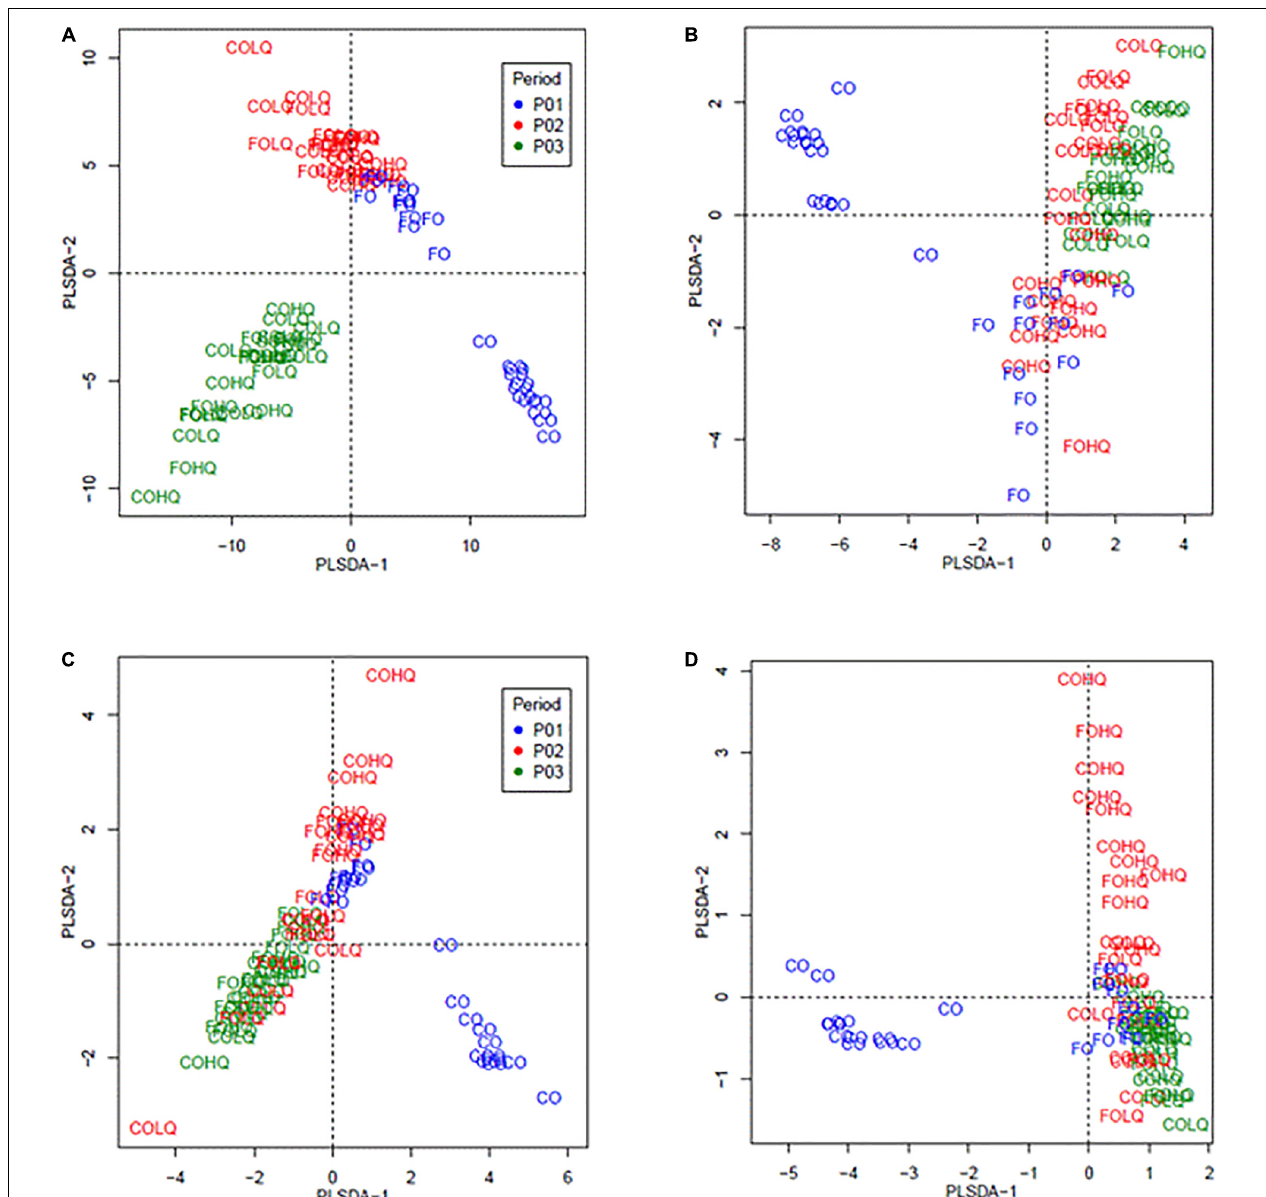
FIGURE 2 | Partial least square discriminant analysis (PLSDA) of the bacteria community at the genus level and archaea community at the species level from calves fed different treatments and treatment combinations in three sampling phases. Dietary treatments corresponded to: phase 1 (P01), concentrate (CO) vs. pasture (FO); and phase 2 (P02) high-quality (HQ) vs. low-quality (LQ) pastures. The treatment groups analyzed by phase were as follows: phase 1 (P01; blue) corresponded to groups from FO and CO; phase 2 (P02; red) and phase 3 (P03; green) were the groups formed by the combination of dietary treatments from P01 and P02, resulting in FOHQ, FOLQ, COHQ, and COLQ. (A) PLSDA of the bacteria community—364 bacterial genera, (B) PLSDA of the abundant ( > 0.7%) bacteria—25 abundant genera, (C) PLSDA of the archaea community—17 archaeal species, and (D) PLSDA of the abundant ( > 1.0%) archaea—7 abundant